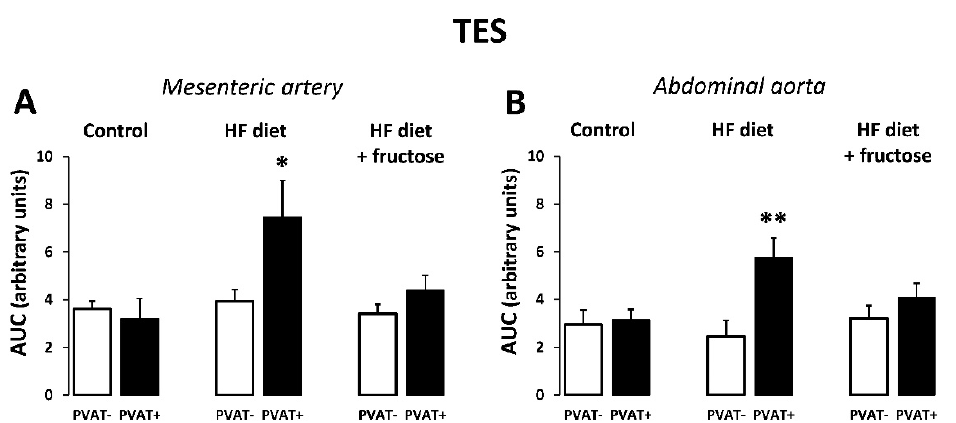
Figure 3. Frequency-dependent contractile responses to transmural electrical stimulation in PVAT(+) ( A ) and PVAT( − ) ( B ) preparations of abdominal aorta from Wistar–Kyoto rats: control, treated with high-fat (HF) diet, and treated with HF diet + fructose. * p < 0.05 vs. HF diet + fructose; + p < 0.05 vs. control. Values represent means ± SEM; n = 6. The AUC values obtained from frequency-dependent neurogenic contractions were higher in PVAT(+) compared to PVAT(-) preparations in the HFD-treated rats, though not in control or in fructose-combined HFD-treated rats (Figure 4).